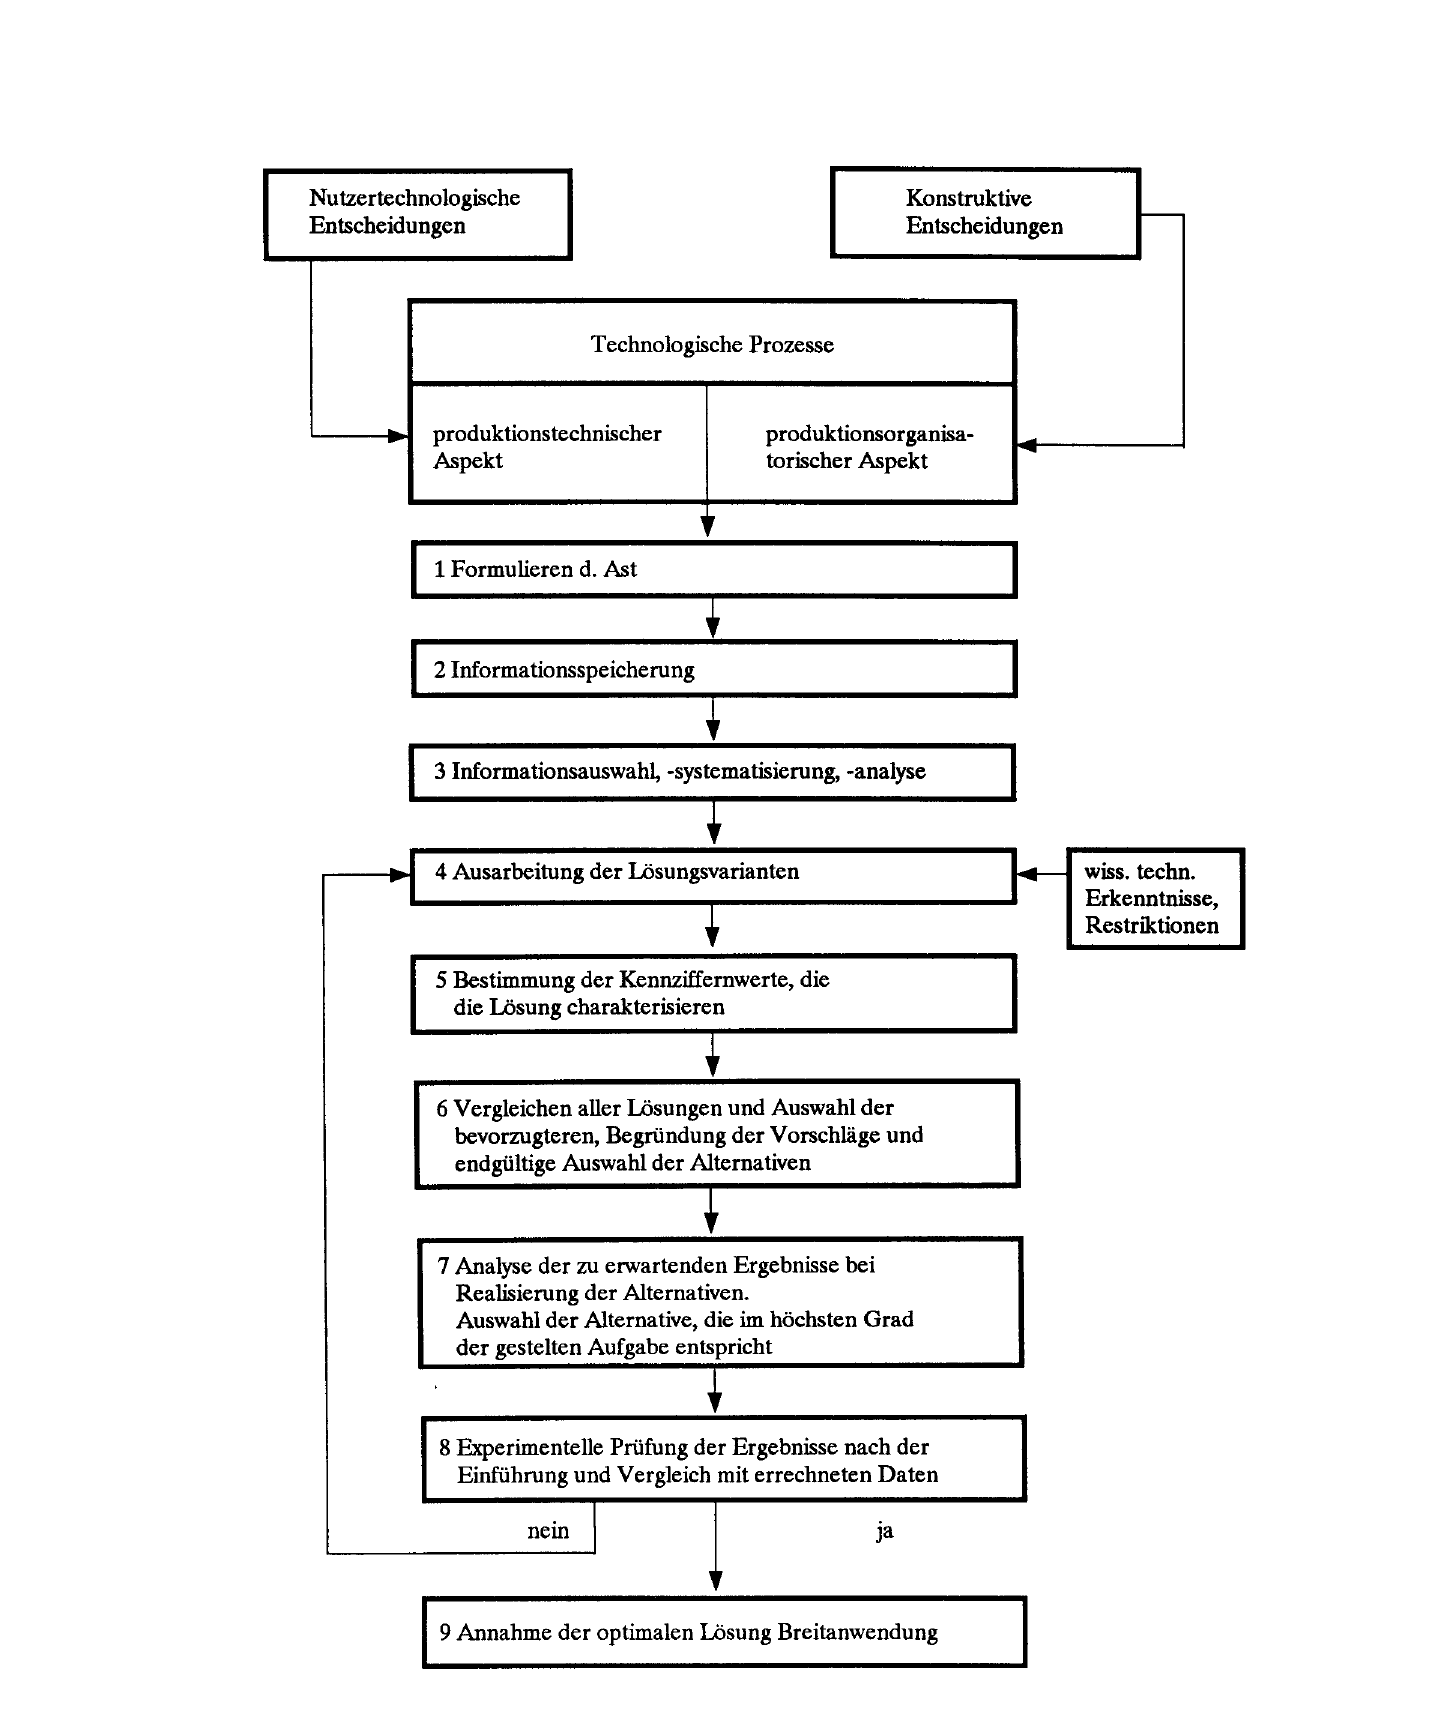
Bild 4. Entwicklung optimaler technisch-technologischer LOsungen